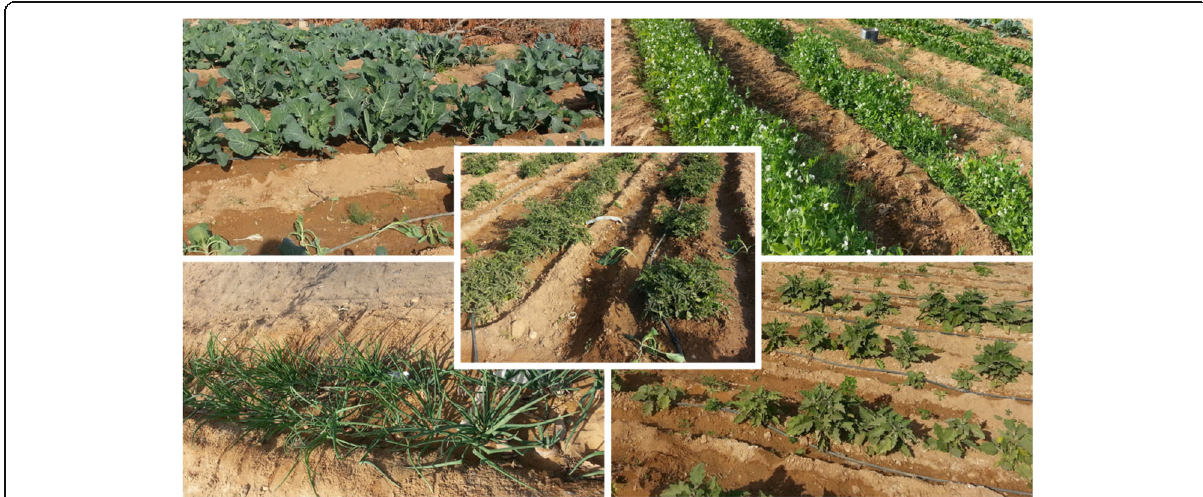
Fig. 2 Photographs showing some cultivated vegetables and sandy nature of soil in Orabi farms